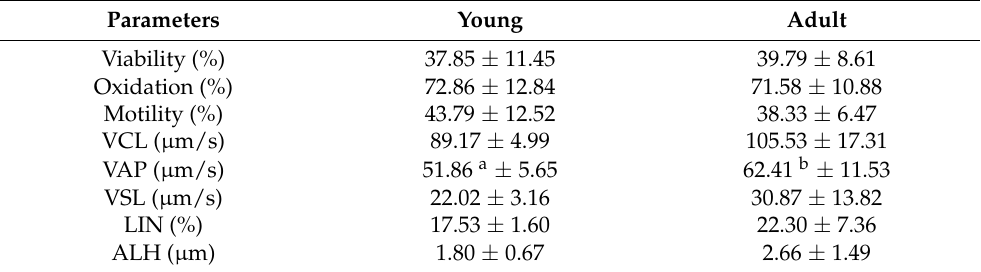
Table 1. Viability, reactive oxygen species generation and CASA parameters (mean ± SD) of thawed bull semen in relation to their age; VCL = curvilinear velocity; VSL = straight line ve- locity; VAP = average path velocity; LIN = linearity; ALH = amplitude of lateral head displacement; n = 6 in each group. Different letters indicate significant differences between groups ( p ≤ 0.05).